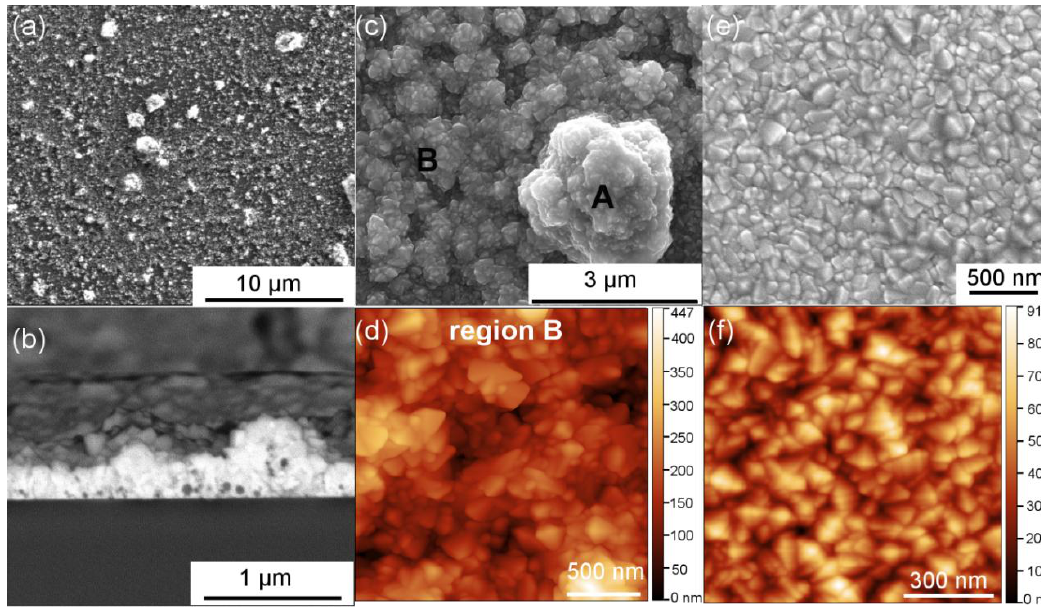
Figure 1. ( a ) Scanning electron microscopy (SEM) image of a 2 wt % Al 2 O 3 nanoparticle suspension spin-coated on glass substrate; ( b ) Cross-sectional and ( c ) plane-view SEM images of a 1 wt % Al 2 O 3 -FTO nanocomposite with its region B examined in ( d ) atomic force microscopy (AFM) (2 × 2 μm 2 ) image; ( e ) Plane-view SEM and ( f ) AFM (1 × 1 μm 2 ) images of a reference flat FTO.